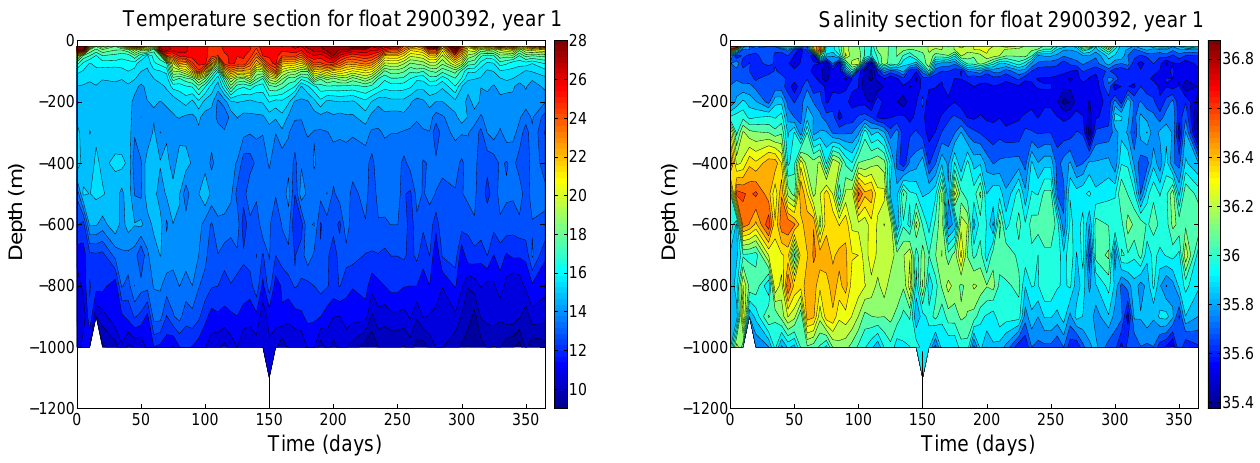
Fig. 9. Vertical sections of temperature (in ◦ C, left) and of salinity (right) along float 2900392 trajectory for year 1. Figure 9: Vertical sections of temperature (in o C , left) and of salinity (right) along float 2900392 trajectory for year 1.